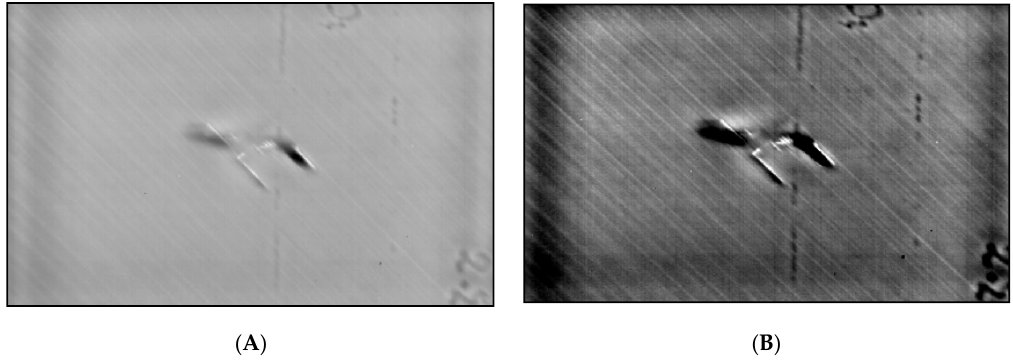
Figure 11. ( A ) Post-processed principal component technique (PCT) thermal output data. ( B ) The contrast difference can be made clearer using colour thresholding to help visualise the real significance of the impact damage.